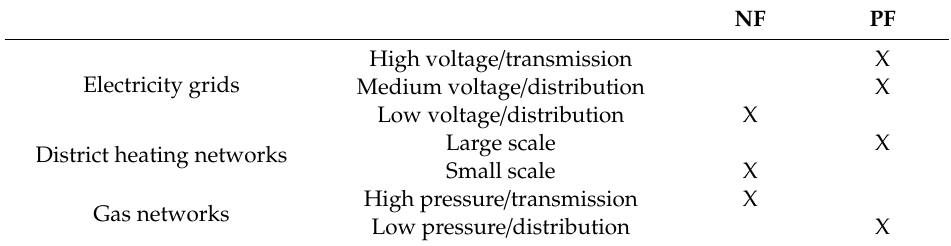
Table 12. Proposed use of NF and PF for di ff erent energy carriers and types of